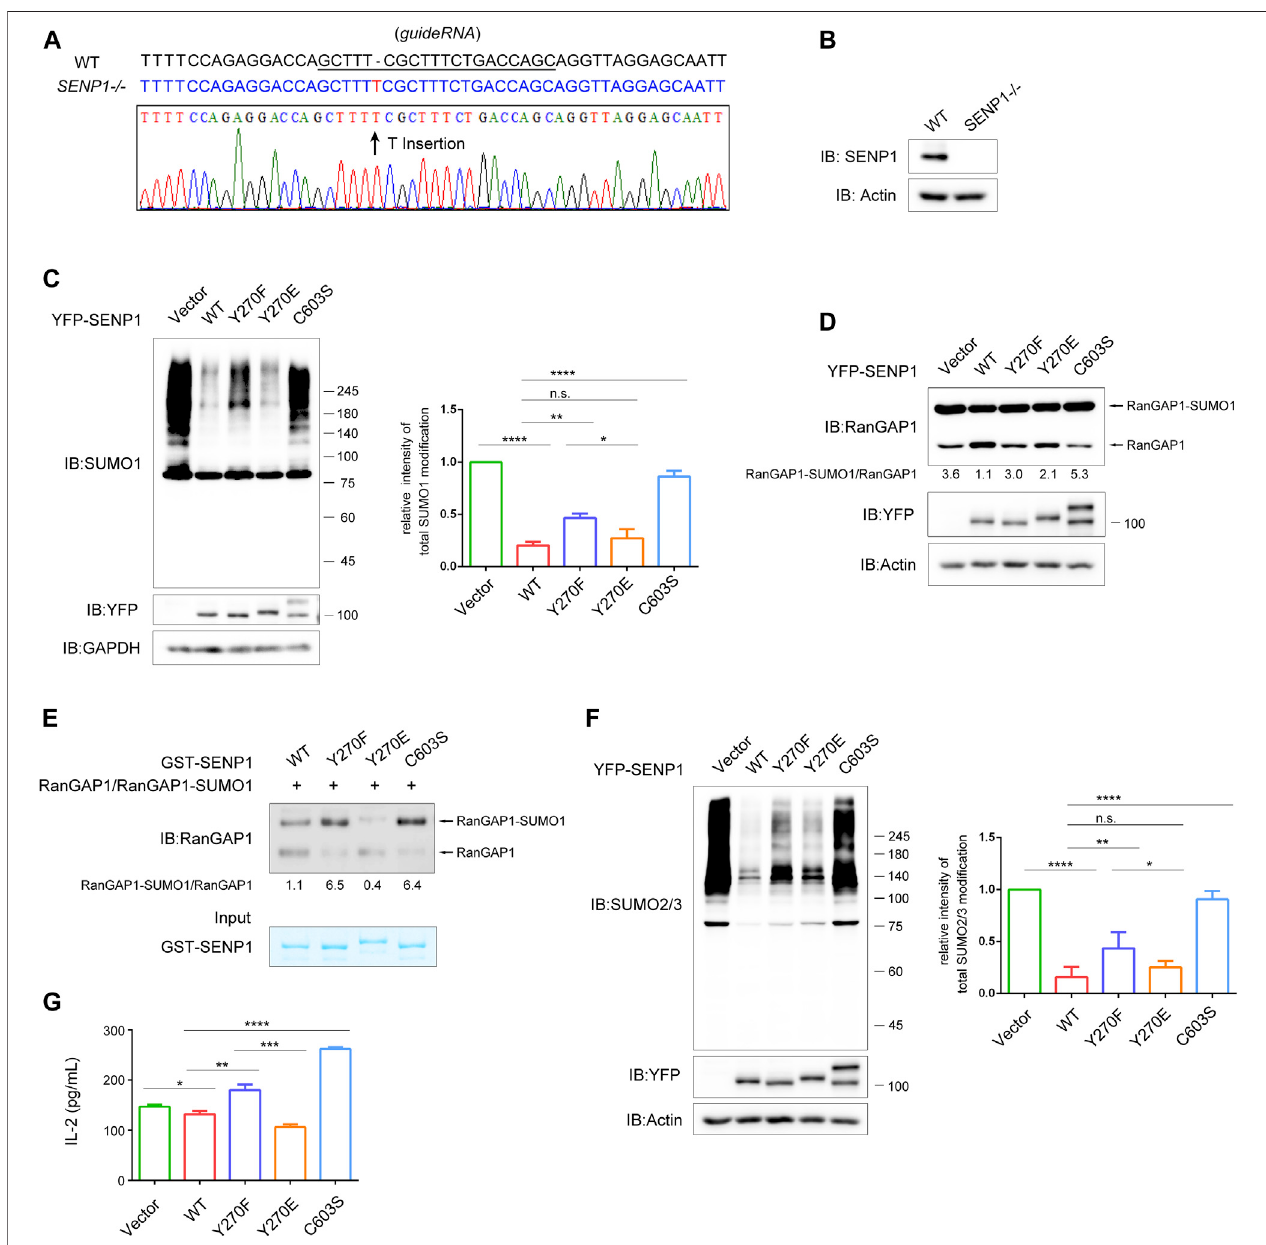
FIGURE 5 | SENP1 Y270 phosphorylation in fl uences its isopeptidase activity both in vivo and in vitro . (A) Sequence alignment of SENP1 genomic fragment (WT) and the CRISPR/Cas9-edited SENP1 genomic fragment in the SENP1 − / − T cells (top). The underlined sequence represents the sgRNA. (B) The expression levels of SENP1 in WT and SENP1 − / − T cells examined by western blot. (C) In vivo SUMO1-pro fi ling assay of SENP1 − / − T cells with rescue expression of YFP-SENP1 WT or its mutants or empty vector. GAPDH was blotted as loading control. The densitometric quanti fi cation of total SUMO1 modi fi cation (the relative intensity of the control was set as 1) is shown on the right. (D) In vivo isopeptidase activity analysis of SENP1 WT and its mutants. With rescue expression in SENP1 − / − T cells as in (C) , cell lysateswere analyzed forendogenoustotalRanGAP1(includingRanGAP1and RanGAP1-SUMO1) bywesternblot(top).The densitometric quanti fi cationoftheratioof RanGAP1-SUMO1/RanGAP1 is shown below. The expression of SENP1 WT and its mutants and actin (loading control) are shown (bottom). (E) In vitro isopeptidase activity assay of SENP1 WT and its mutants. The experiment was performed by incubating RanGAP1-SUMO1 protein (substrate) immunoprecipitated from SENP1 − / − T cell lysates with GST-SENP1 WT and its mutants Y270F, Y270E, and C603S (enzyme), respectively, at 37 ° C for 20 min, followed by immunoblot (top). The densitometricquanti fi cationoftheratioofRanGAP1-SUMO1/RanGAP1isshownbelow.Theinputofpuri fi edGST-SENP1proteinswascheckedbyCoomassiestaining (bottom). (F) Invivo SUMO2/3-pro fi lingassayof SENP1 − / − TcellswithrescueexpressionofYFP-SENP1WToritsmutantsoremptyvector.Actinwasblottedasloading control. The densitometric quanti fi cation of total SUMO2/3 modi fi cation (the relative intensity of the control was set as 1) is shown on the right. (G) The effect of SENP1 WT and its mutants on the production of IL-2 in T cells. Jurkat E6.1 T cells were transfected with empty vector or YFP-SENP1 WT or its mutants Y270F, Y270E, and C603S and then stimulatedwithanti-CD3plus anti-CD28for 24 h. The concentration ofIL-2 inculture supernatants was determined byenzyme-linked immunosorbent assay (ELISA). n.s., not signi fi cant. * p < 0.05, ** p < 0.01, *** p < 0.001, and **** p < 0.0001 (two-tailed unpaired Student ’ s t -test).